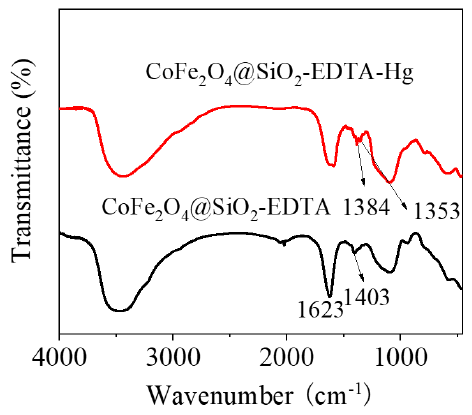
Figure 17. Possible mechanism of adsorption of mercury.